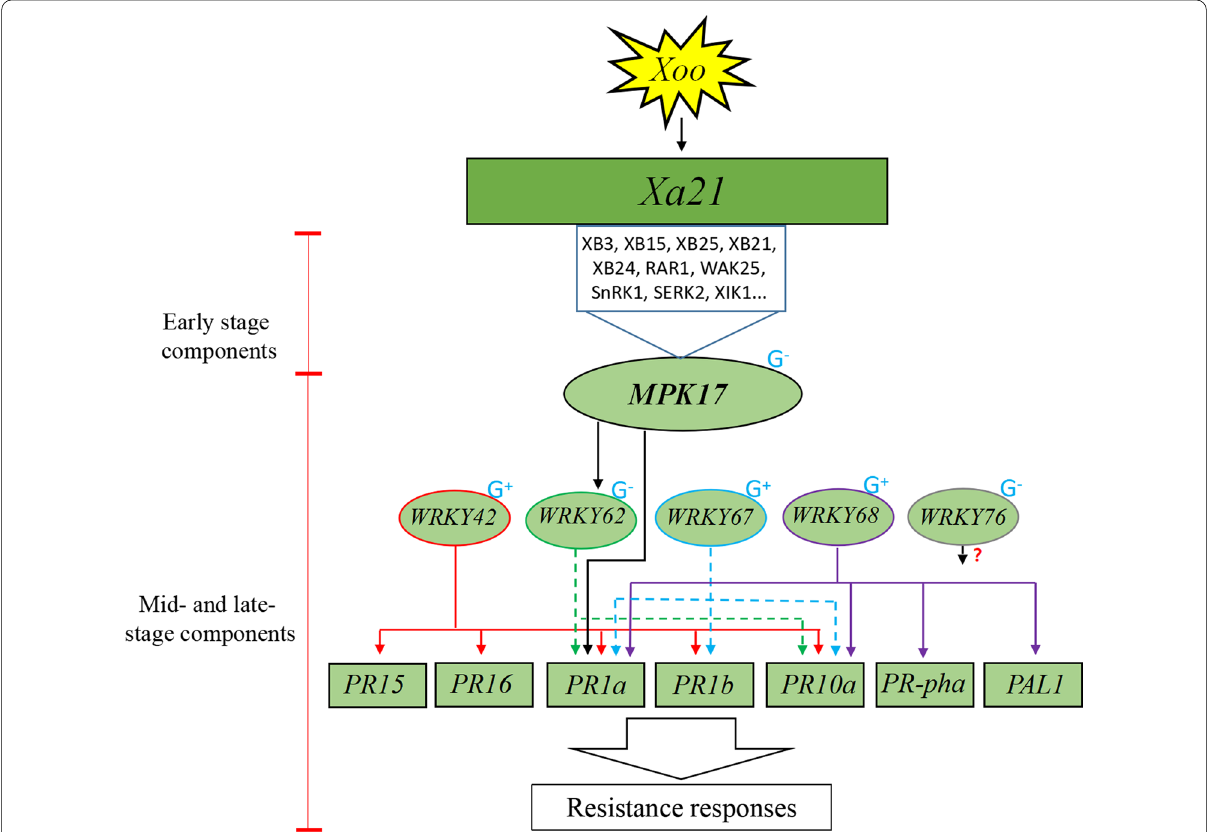
Fig. 11 A model for the mid- and late-stages of the Xa21 -mediated immunity. G + and G − denote the genetic evidence that supports a positive or negative regulator, respectively; solid and dotted lines denote WB or RT-PCR evidence,